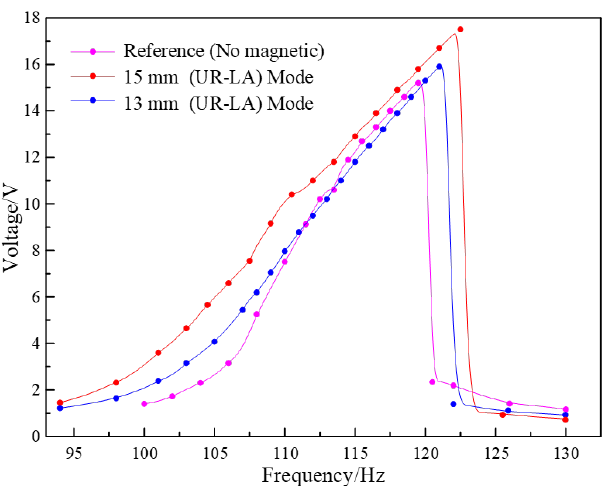
Figure 11. The load voltage in frequency domain under upper-repulsion – lower-attraction modes.